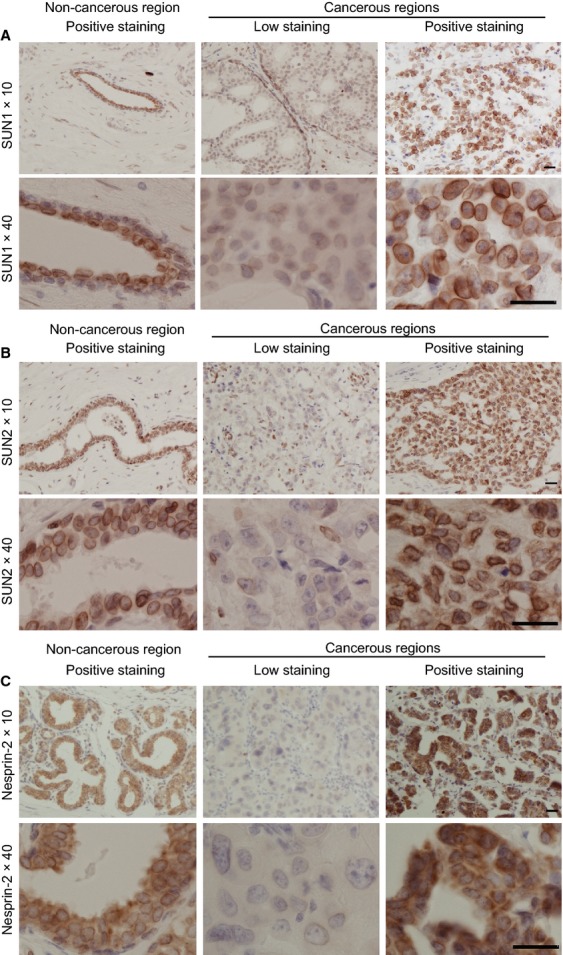
Immunohistochemical staining for SUN1, SUN2, and nesprin-2. Specimens of breast tumor were stained using pAbs against SUN1 (A), SUN2 (B), and nesprin-2 (C). Representative cases including noncancerous (left) and cancerous regions (middle and right) are shown. The upper panels were obtained at lower magnification than the lower panels. Bar, 50 μm.